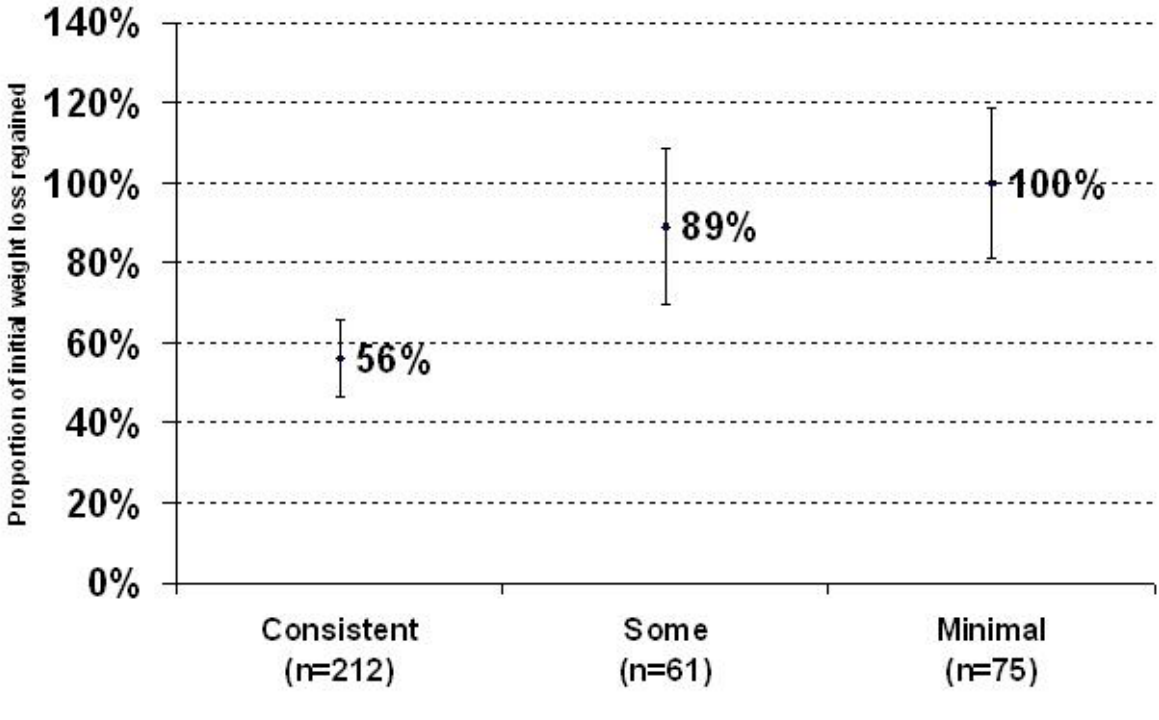
Figure 3. Proportion of initial weight loss regained for each website use category shown as 95% confidence interval for the mean (two-tail P value